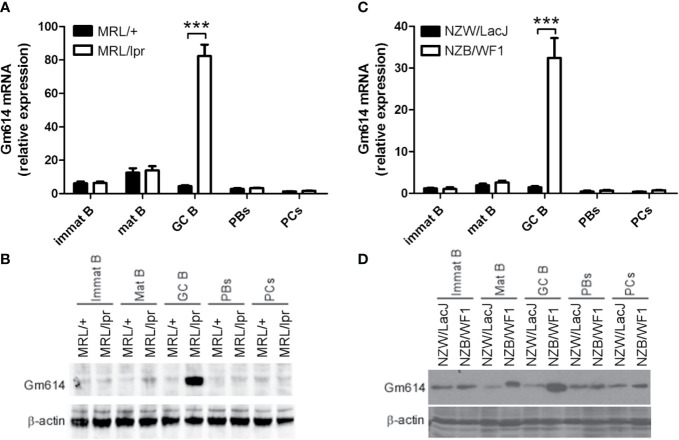
Gm614 was highly expressed in germinal center (GC) B cells from lupus-prone mice. Immature B cells (Immat B), mature B cells (Mat B), GC B cells, plasmablasts (PBs), and plasma cells (PCs) from splenocytes of six lupus-prone MRL/lpr mice and their control MRL/+ mice (A, B) or lupus-prone NZB/WF1 mice and their control NZW/LacJ mice (C, D) were sorted by flow cytometry (FACS), and subjected to qPCR (A, C) and western blot (B, D) analysis. (A–D) Data represent three independent experiments. (A, C) Two-Way ANOVA were followed by Bonferroni post-tests (n = 6), Error bars, s.e.m., ***p < 0.001.